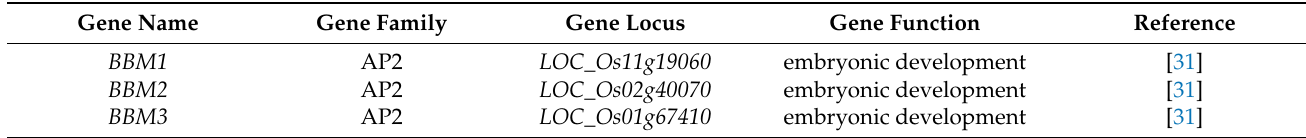
Table 5. Genes associated with embryogenesis in rice.